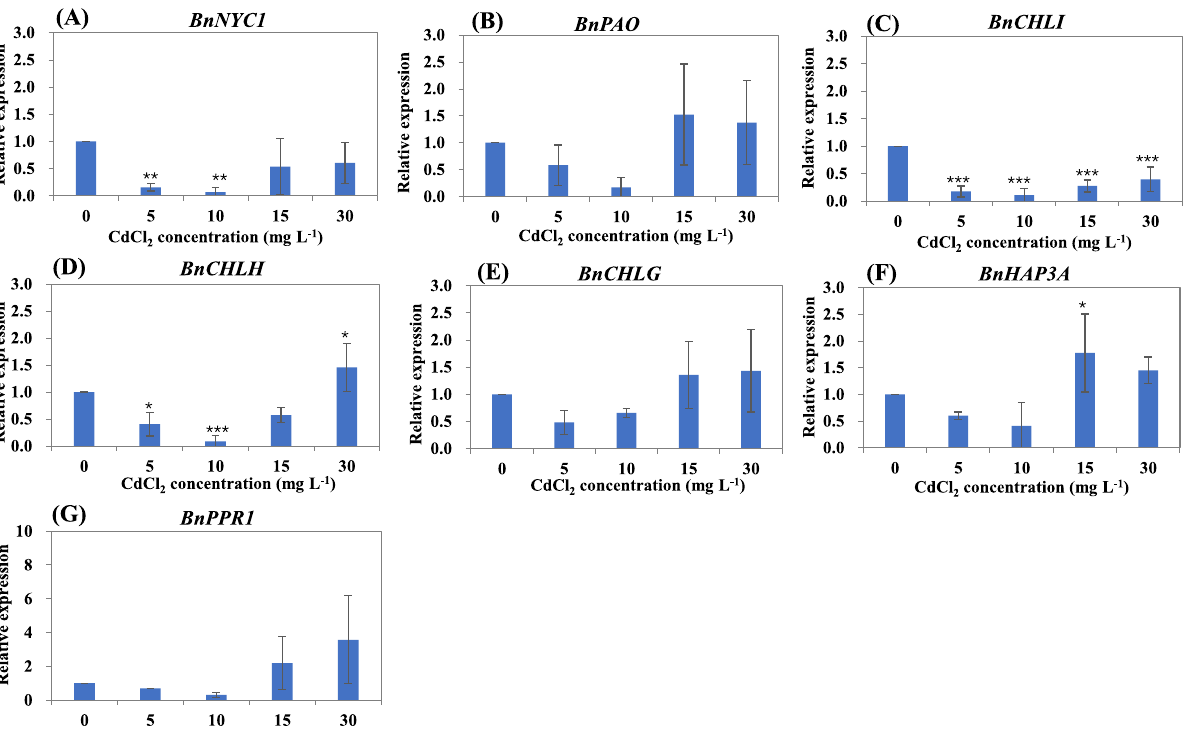
Figure 3. Relative expression of the chlorophyll synthesis related genes ( BnPAO , BnNYC1 ) and the chlorophyll degradation related genes ( BnCHLH , BnCHLI , BnCHLG , BnHAP3A and BnPPR1 ) in leaves of ramie under Cd stress. The 2 −ΔΔCt method was used to calculate the relative expression of the selected genes. Data are means ± SD of three biological replicates. Each replicate consisted of material from ten plants. *, ** and ***denote statistically significant differences from the control (0 mg L −1 ) at P < 0.05, P < 0.01 and P < 0.001,